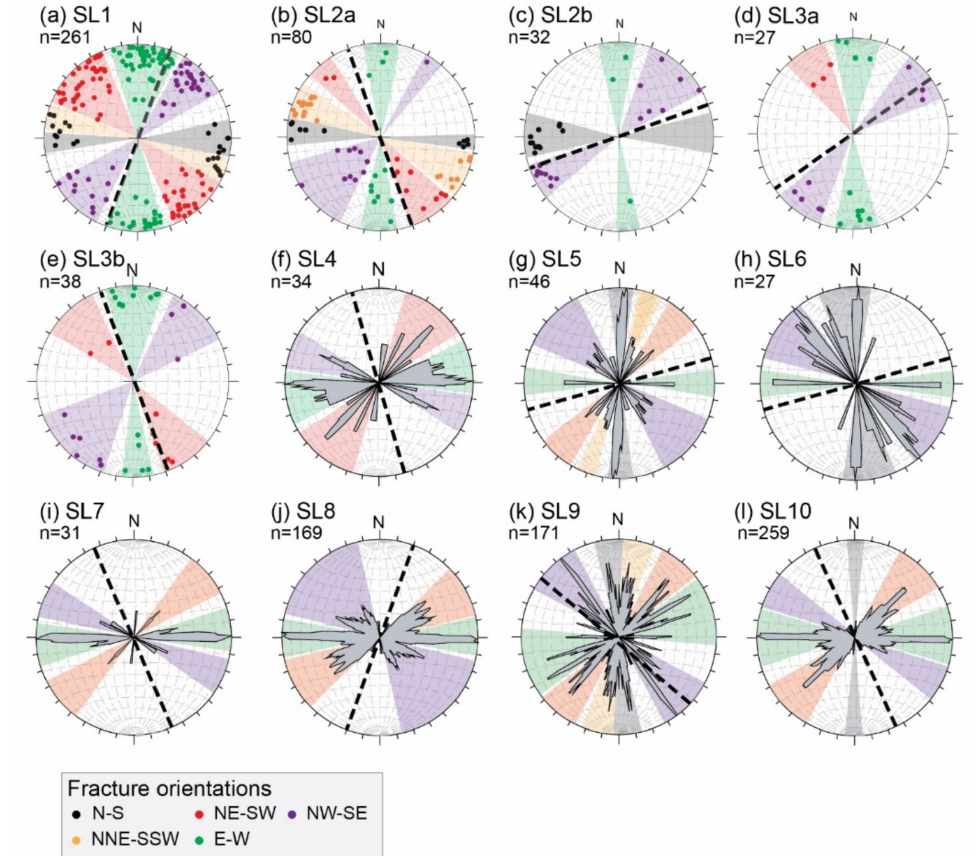
Figure 5. Fracture orientation distributions of the NH studied outcrops ( a – l ). ( a – e ) The fracture orientation distributions are represented into Schmidt canvas, lower hemisphere because they contain strike and dip measurements. ( f – l ) Fracture orientation distributions are represented by rose diagrams because they contain only dip direction measurements. Each direction rose diagram of direction is expressed with classes of 5 ◦ . The dashed lines indicate the direction of the scanline. n: Number of data. See legend in the figure for